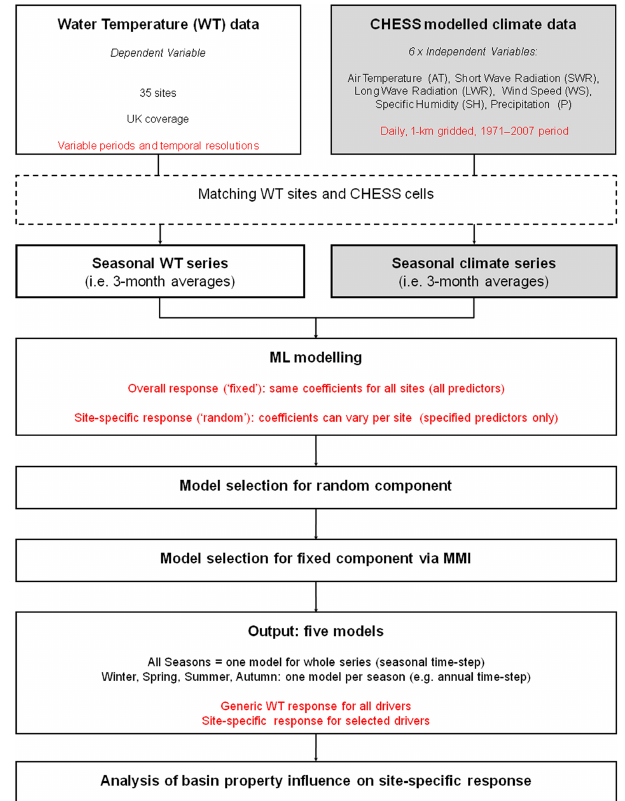
Figure 3. Study flow